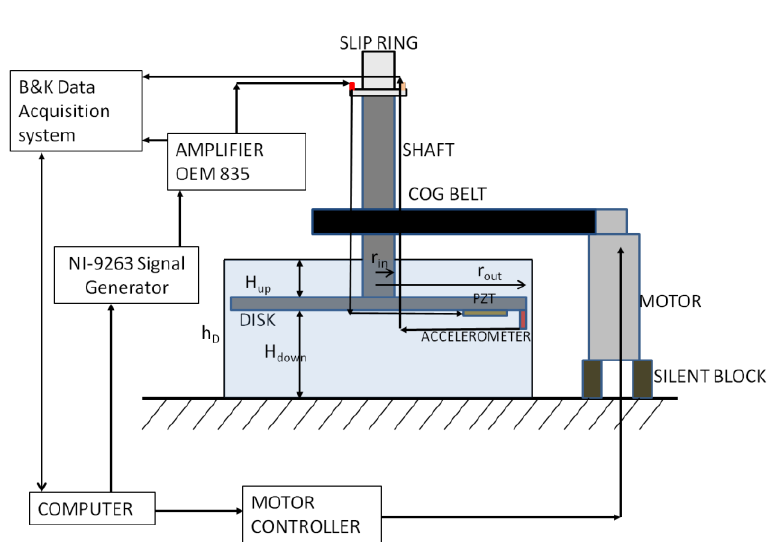
Figure 5. Rotating disk test